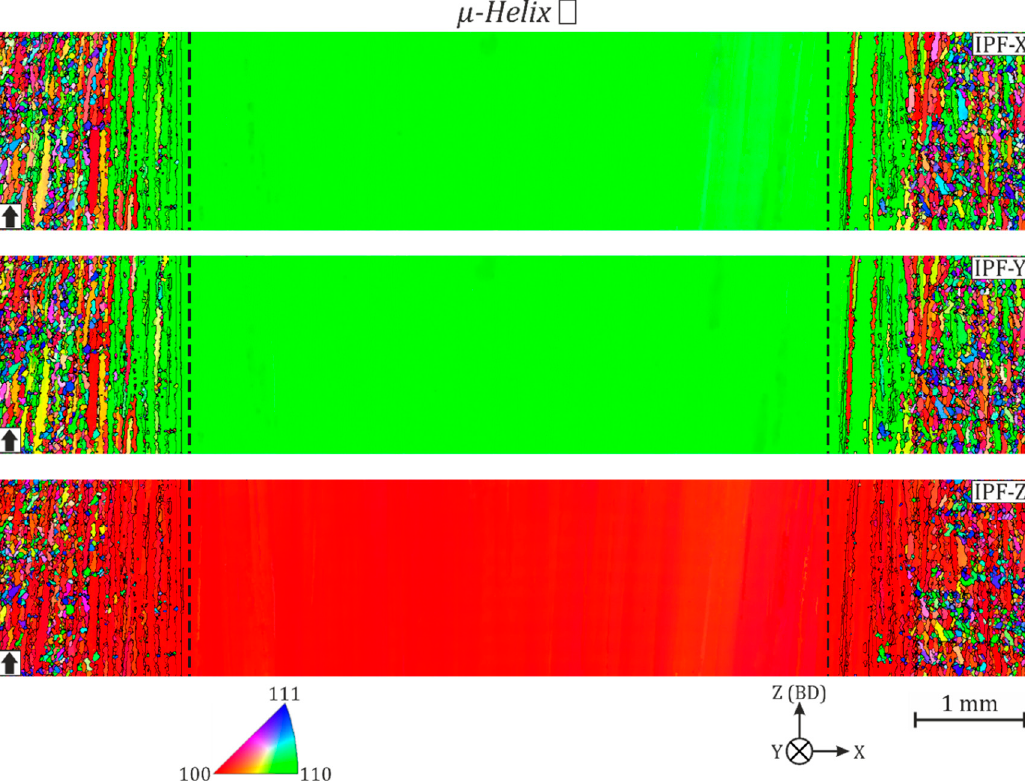
Figure 8. Large area EBSD-IPF maps of a cuboid sample manufactured with the µ-Helix parameter setting. The build direction is indicated by the black arrows. Grain boundaries with a misorientation angle of > 10° are highlighted with black lines. The dashed lines indicate the region of interest for the pole figures.